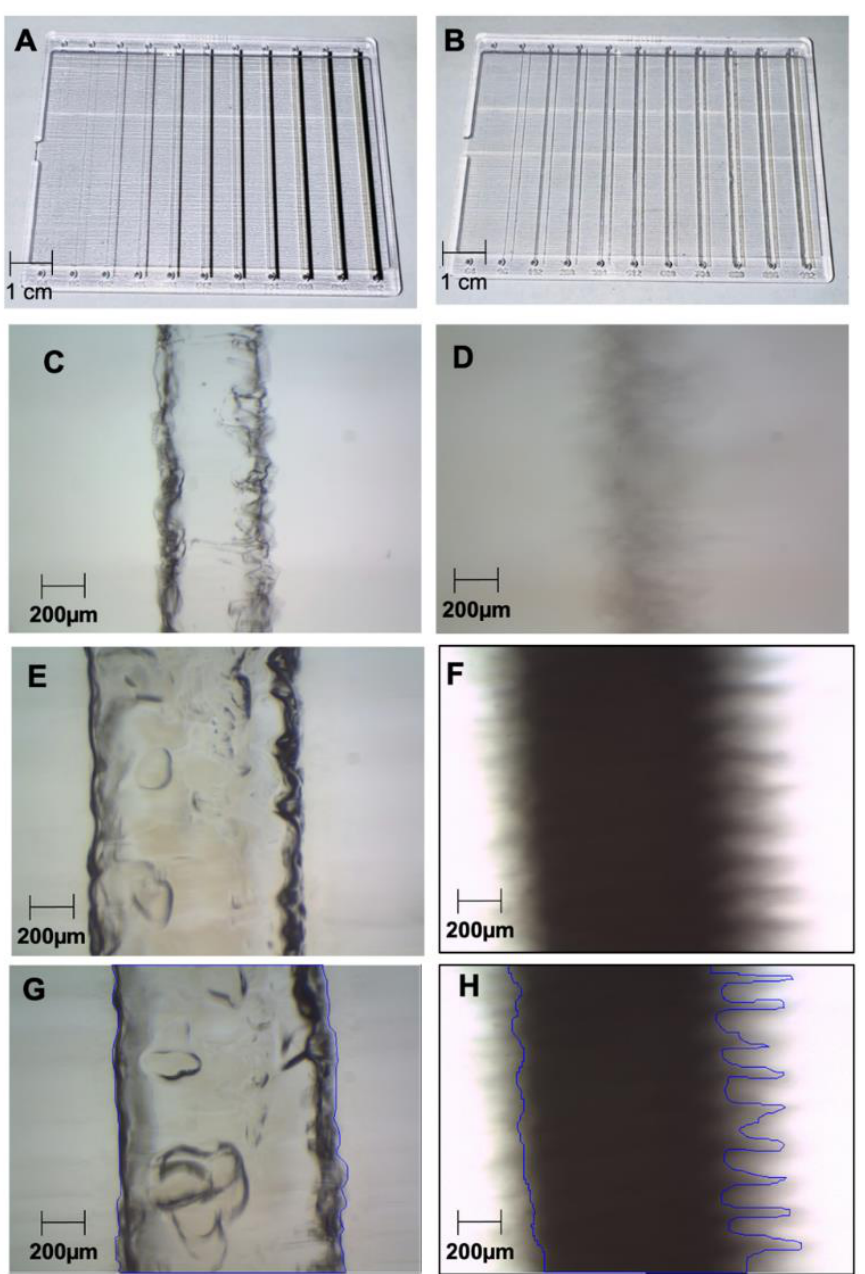
Figure 1. Chips and measurements. An array of flow channels was 3D-printed in wax, with matching reference channels in black resin ( A ) and wax ( B ), all encapsulated in transparent resin. All channels had a square cross-section with swept lateral dimension. The three wax/wax chips (one shown in ( B ) were put through the channel clearance procedure, while the reference chip ( A ) was not. The results were imaged in the respective pairs ( C ) (cleared flow) and ( D ) (black resin) with planned width 192 µ m; ( E ) (cleared flow) and ( F ) (black resin) with planned width of 992 µ m). The images were uploaded in AutoCAD and framed with polylines ( G ) (cleared flow) and ( H ) (black resin) with planned width of 992 µ m). The respective framed areas were calculated through an AutoCAD function. The area ratio in each pair of images was used in the calculation of the clearance